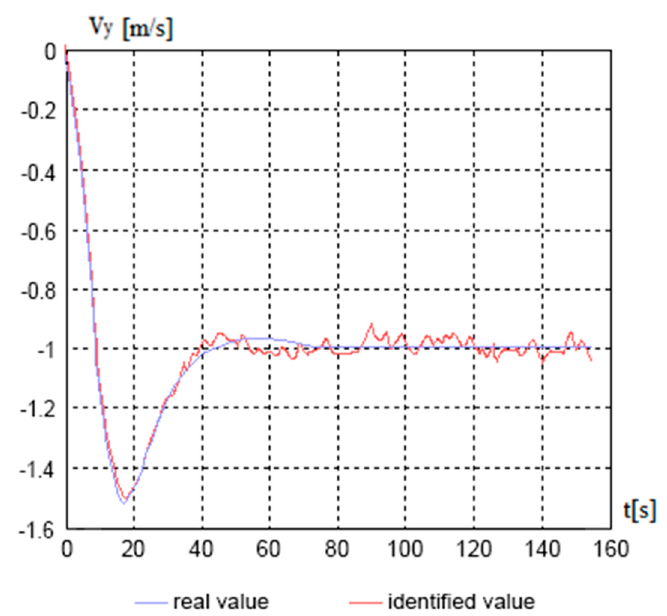
Figure 2. Estimation of the V x component of velocity during circulation.